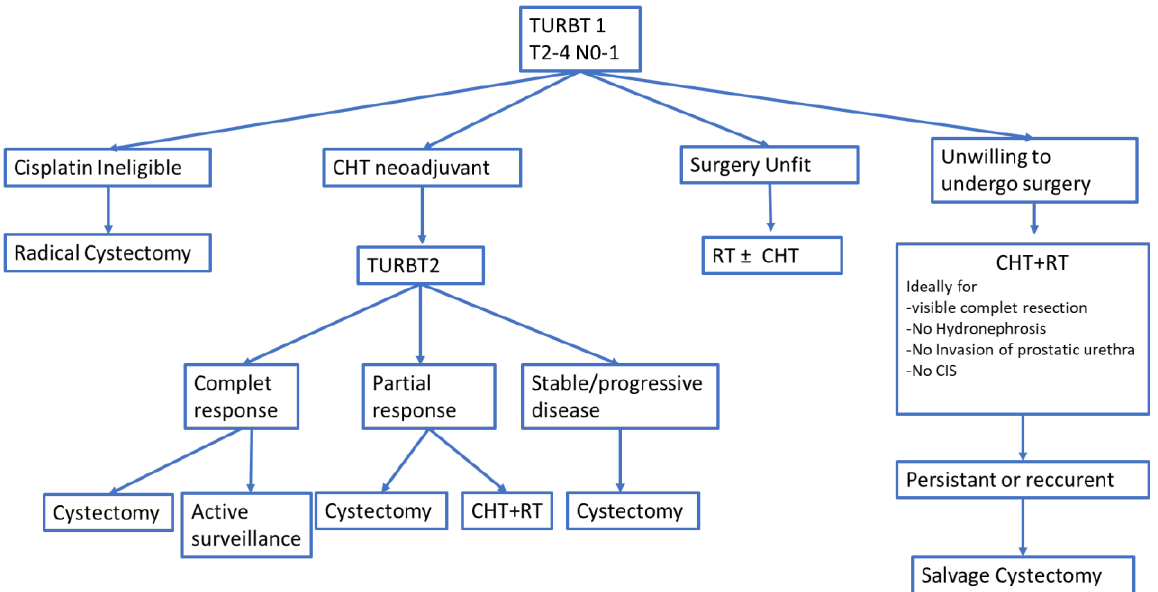
Figure 4. Proposed algorithm for treatment of T 2 – 4 N 0 – 1 M0 transitional BC (bladder cancer). TURBT = transurethral resection of bladder tumor; CHT = chemotherapy; RT = radiotherapy.